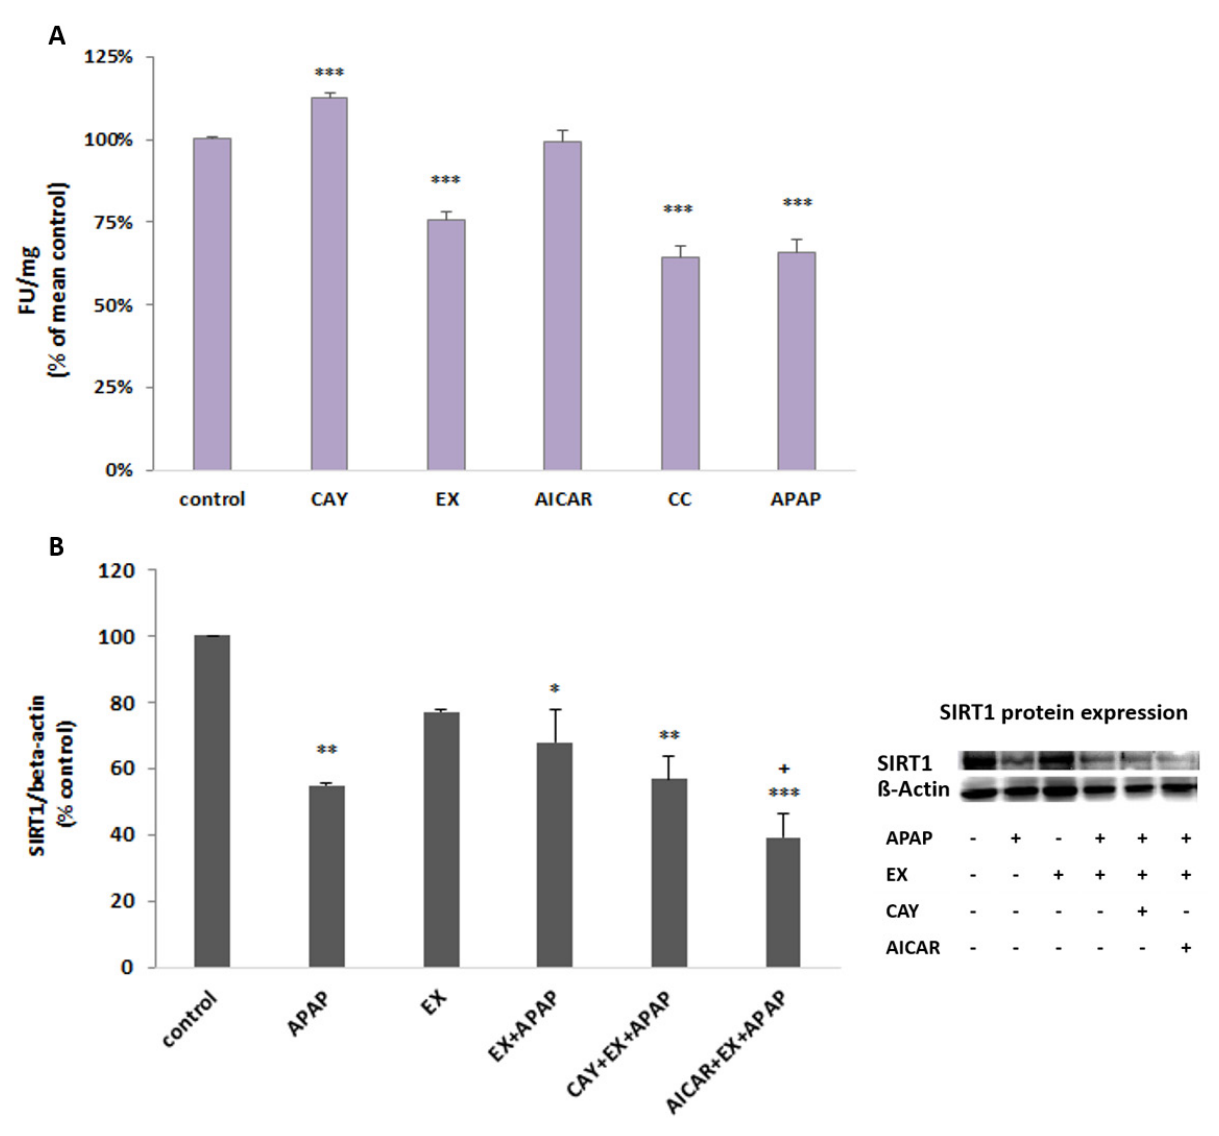
Fig. 4. Effects of acetaminophen (APAP), specific modulators of SIRT1 (activator – CAY10591/CAY and inhibitor – EX-527/EX) and AMPK activator (AICAR) on: A. SIRT1 activity after 4 h, B. SIRT1 protein expression after 24 h; both in cultured primary rat